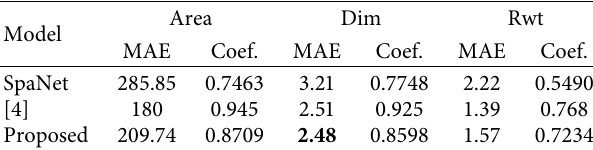
Table 3: Performance evaluation with SOTA and